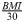
XY calculation plots for the sub-score of each of the four components within SASscore: BMI30, NC40 for females and NC43 for males, SysBP140, ESS11.Each plot highlights with black lines the parameter value for which the respective sub-score equals 1.